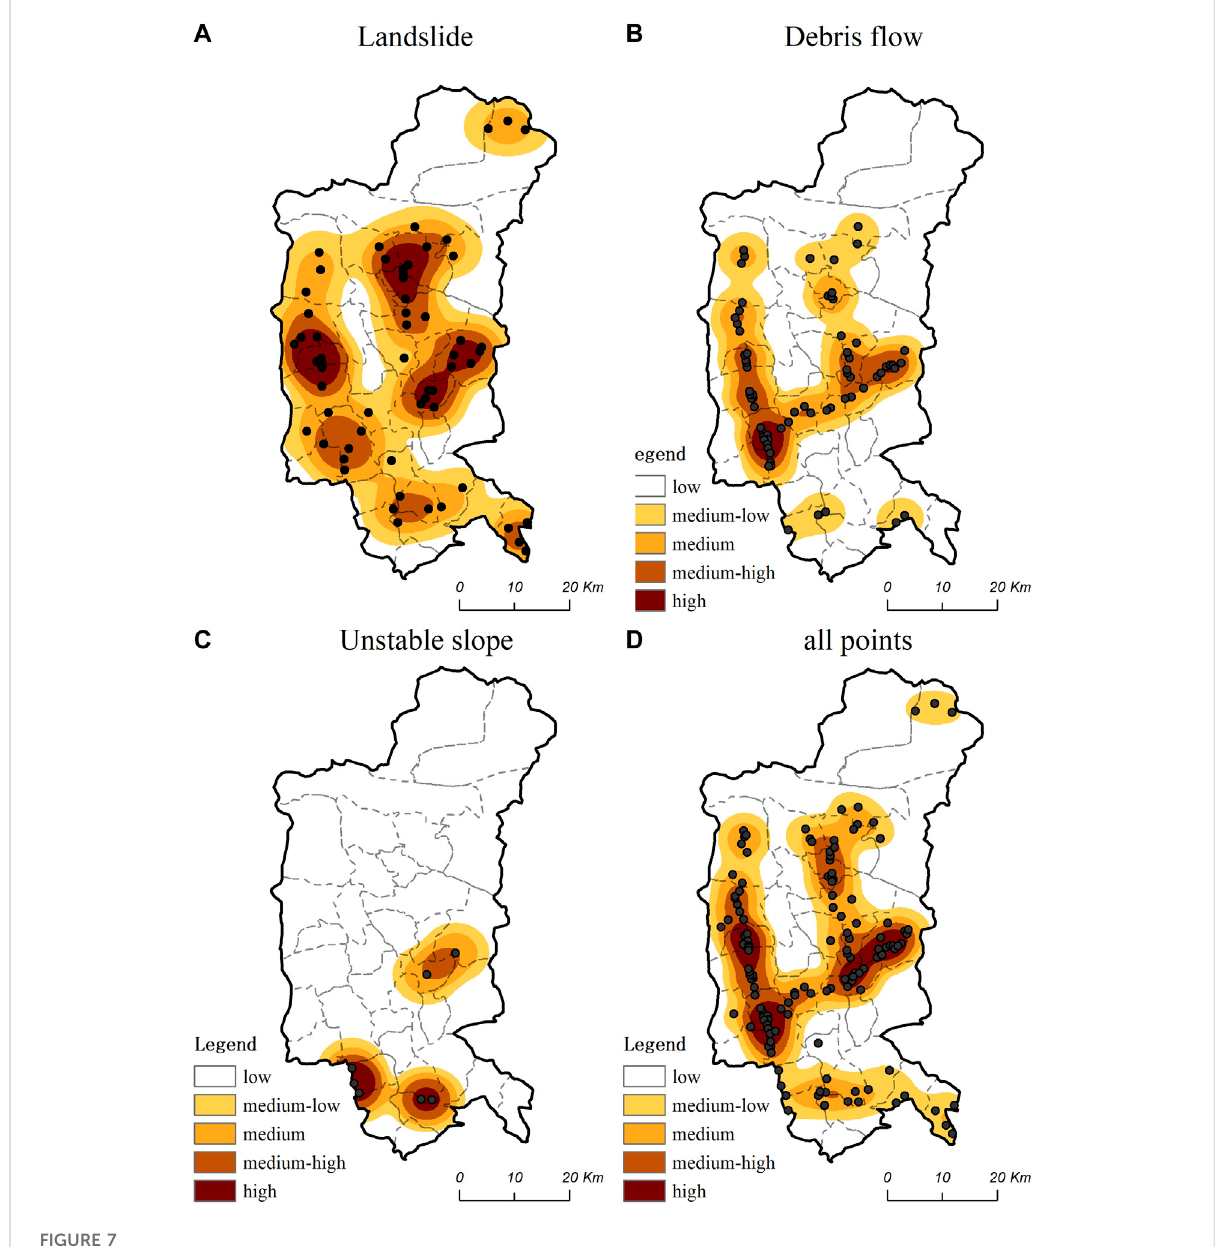
FIGURE 7 Maps of Kernel density of